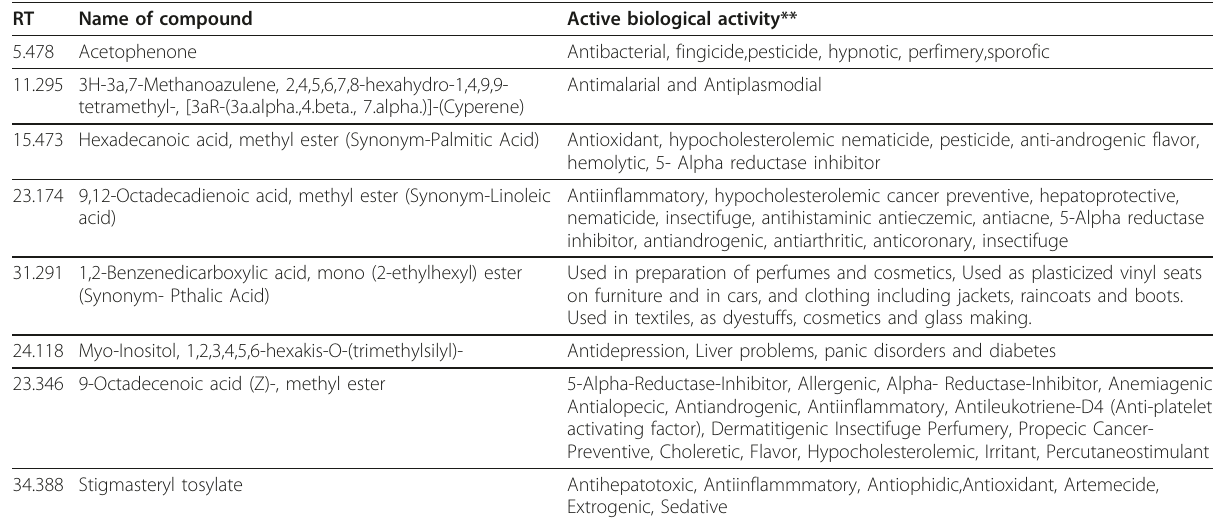
Table 4 Phyto-components and its biological activities obtained through the GC/MS Study of Pyrostegia venusta